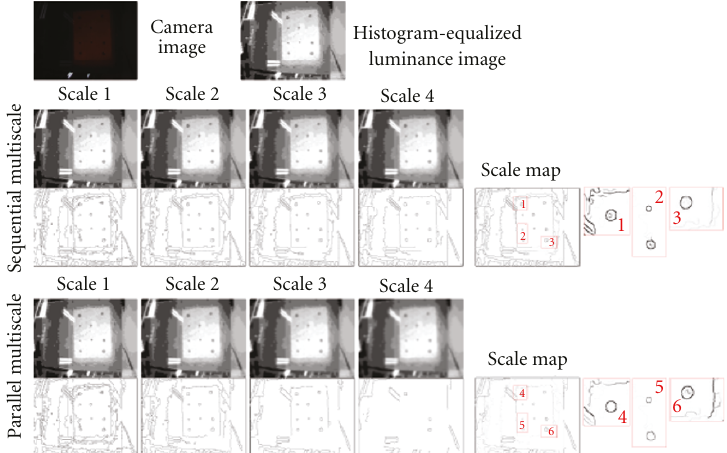
Figure 7: Comparison between the sequential and parallel multiscale detection. Gaussian smooth filter and Canny edge detector are used as the simplification filter and base detector,